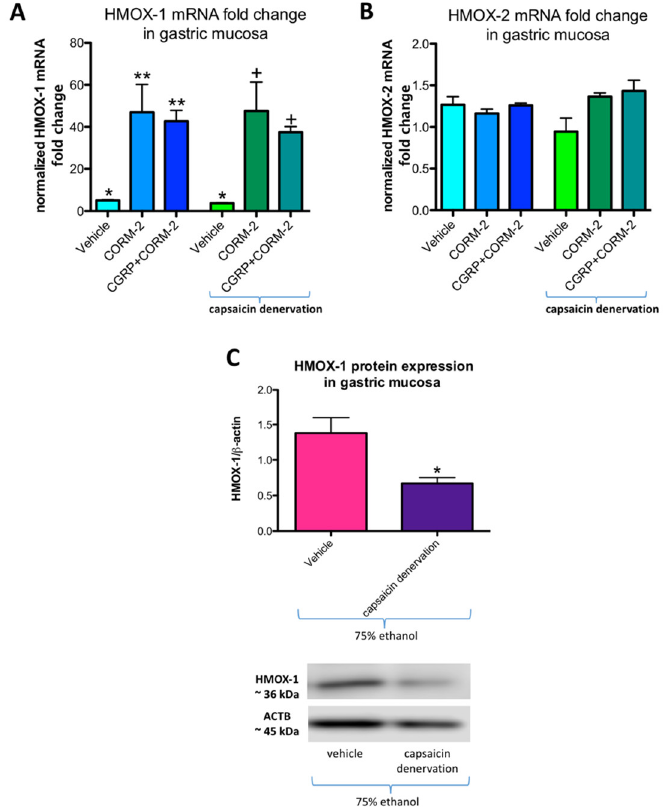
Figure 6. HMOX-1 ( A ) and HMOX-2 ( B ) mRNA fold change in gastric mucosa of rats with or without capsaicin denervation and pretreated with vehicle or CORM-2 (5 mg/kg i.g.) alone or with CGRP- α (10 µ g/kg i.p.) followed by i.g. administration of 75% ethanol. Panel C : gastric mucosal HMOX-1 protein expression in rats administered with 75% ethanol with and without capsaicin denervation. Results are expressed as mRNA fold change of HMOX-1 and HMOX-2 normalized to succinate dehydrogenase complex, subunit A (SDHA) and β -actin. Results are mean ± SEM of 4–5 rats per each experimental group. ( A ) Asterisk indicates a significant change as compared with intact rats ( p < 0.05); double asterisks indicate significant difference as compared with vehicle pretreated group without capsaicin denervation ( p < 0.05); cross indicates significant change as compared with vehicle pretreated group with capsaicin denervation ( p < 0.05). ( C ) Asterisk indicates significant change as compared with gastric mucosa administered with 75% ethanol of rats without capsaicin denervation ( p < 0.05).